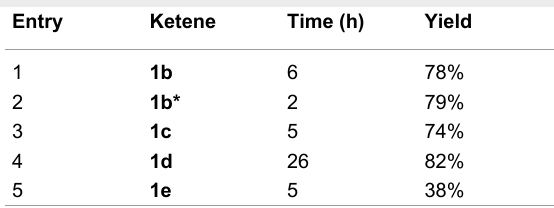
Table 4: Methylenation of silylketenes with the Petasis reagent Entry